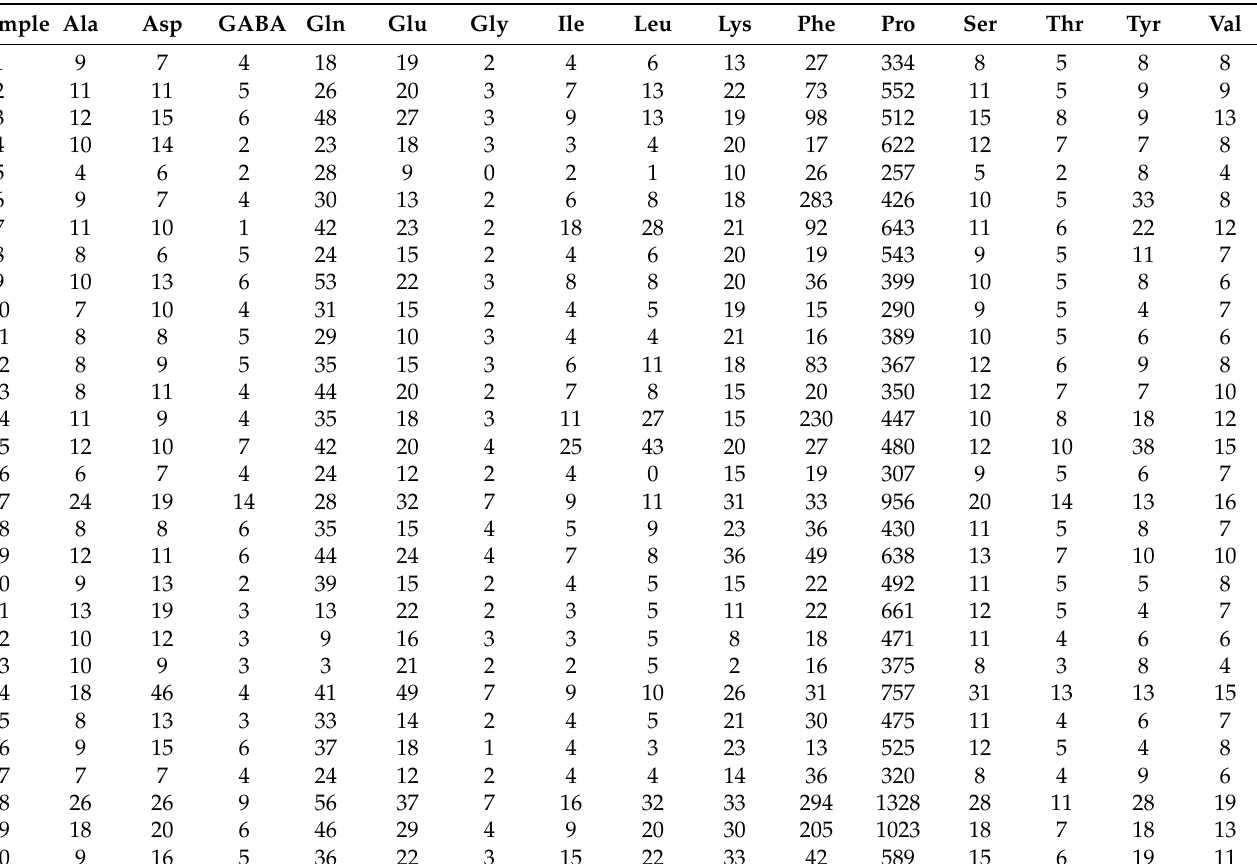
Table 4. The amino acid composition of honeys. Ala—alanine, Asp—aspartic acid, GABA—gamma aminobutyric